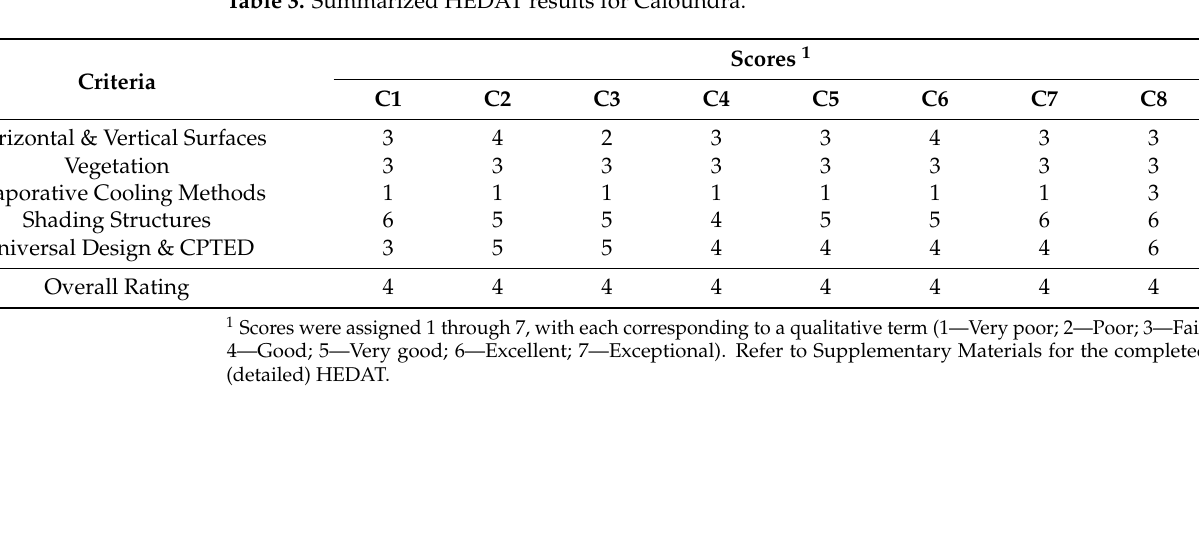
Table 3. Summarized HEDAT results for Caloundra.